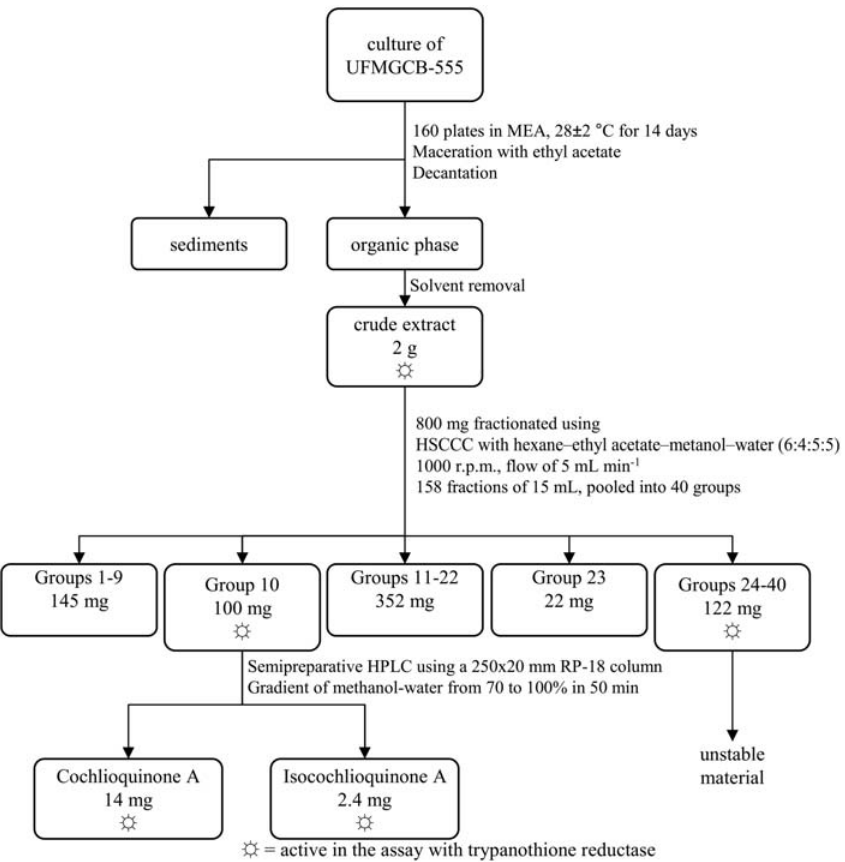
Figure 1. Phylogenetic tree depicting the relationships between UFMGCB-555 and related species. The tree was constructed by neighbor-joining analysis (Kimura-2 parameter) of their ITS domain sequences. Bootstrap percentage from 1000 replicates is shown. The GenBank accession numbers are indicated for each reference sequence. The ITS sequence of Alternaria (AY673074) was used as an outgroup.